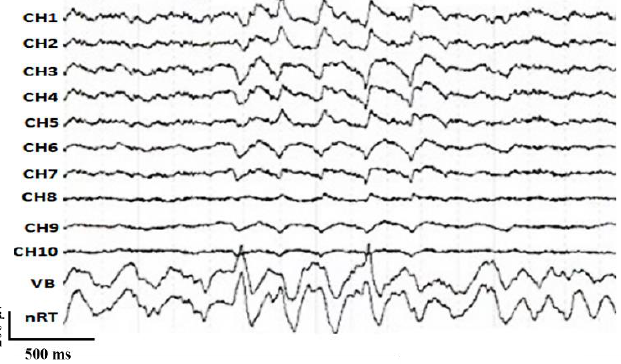
Figure 10. A sample trace of ECoG experiencing absence seizure induced by intraperitoneal injection of γ-butyrolactone (GBL). The number follows the channel montage defined in Figure 9b.